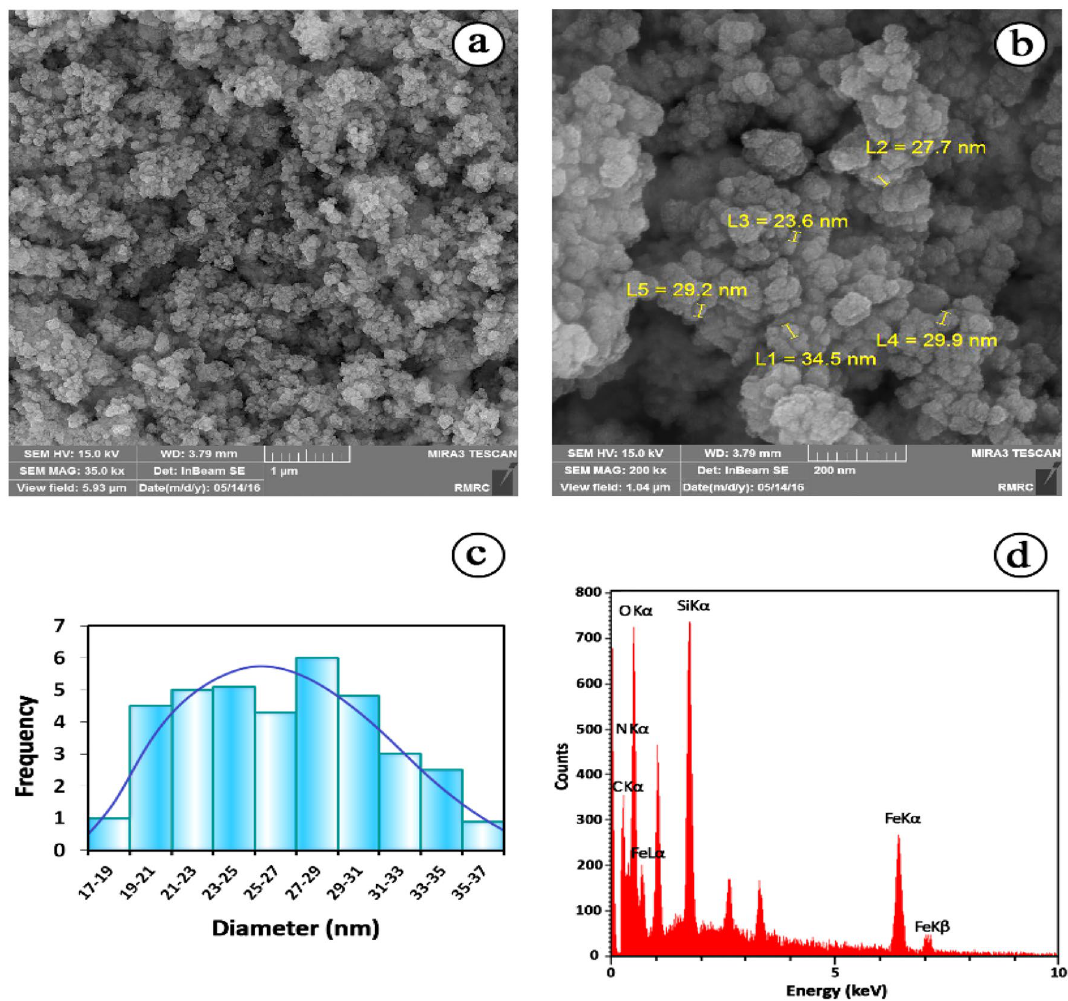
Figure 4. The FE-SEM images ( a ), ( b ), Histogram for particles size ( c ), and EDX spectrum ( d ) of Fe 3 O 4 @SiO 2 @